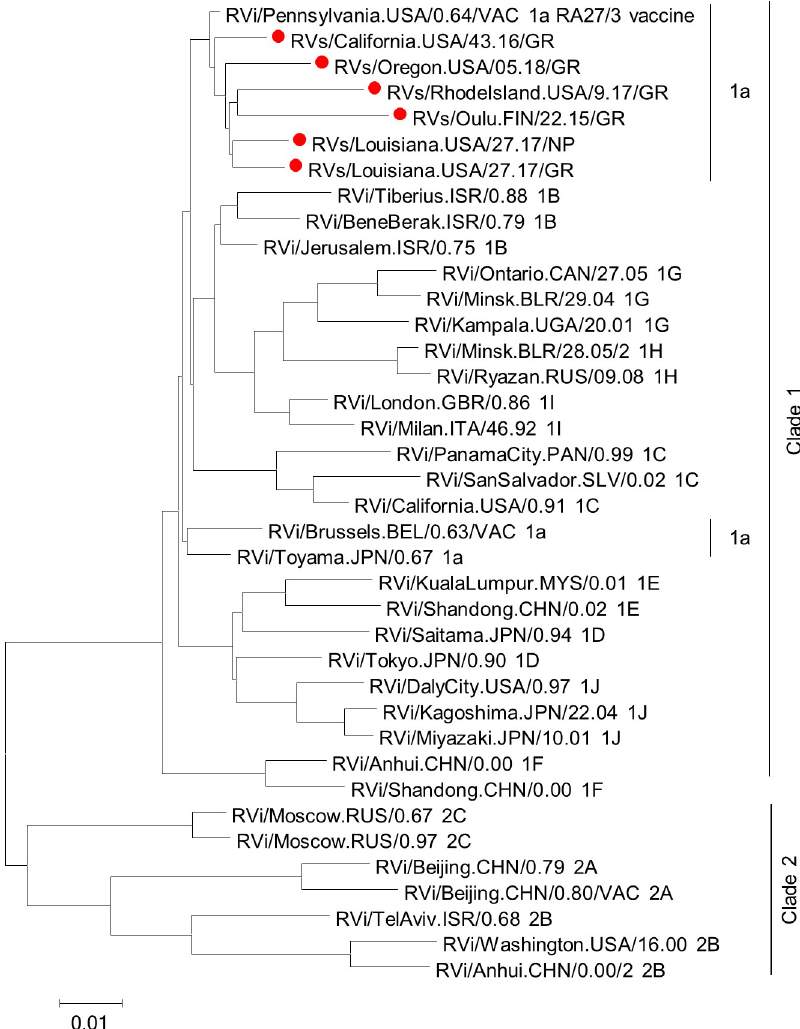
Fig 1. Phylogenetic tree of iVDRV. The genetic relationships between the consensus genome sequences from each original granuloma sample and the whole genomes of the WHO reference viruses were inferred using the Maximum Likelihood method in MEGA7. All taxa are labeled with WHO names with iVDRV sequences marked with red dots. The genetic distances were computed using the Maximum Composite Likelihood method. The scale bar indicates the number of base substitutions per site. RA27/3 and iVDRVs represent a separate branch on the tree with RA27/3 being